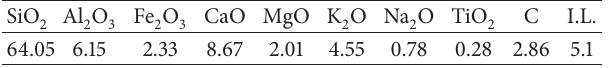
Table 1: Chemical composition of RHA (wt.%).